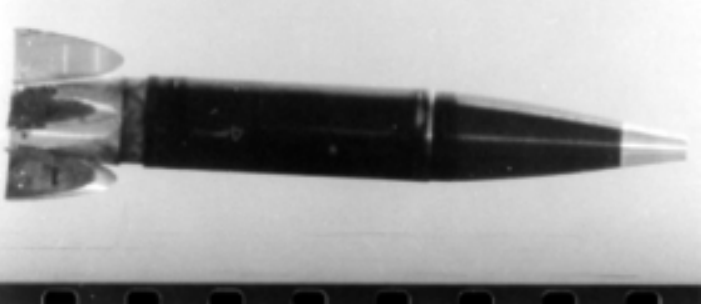
Fig. 9. 34-kg projectile at 16.77 m from the muzzle.